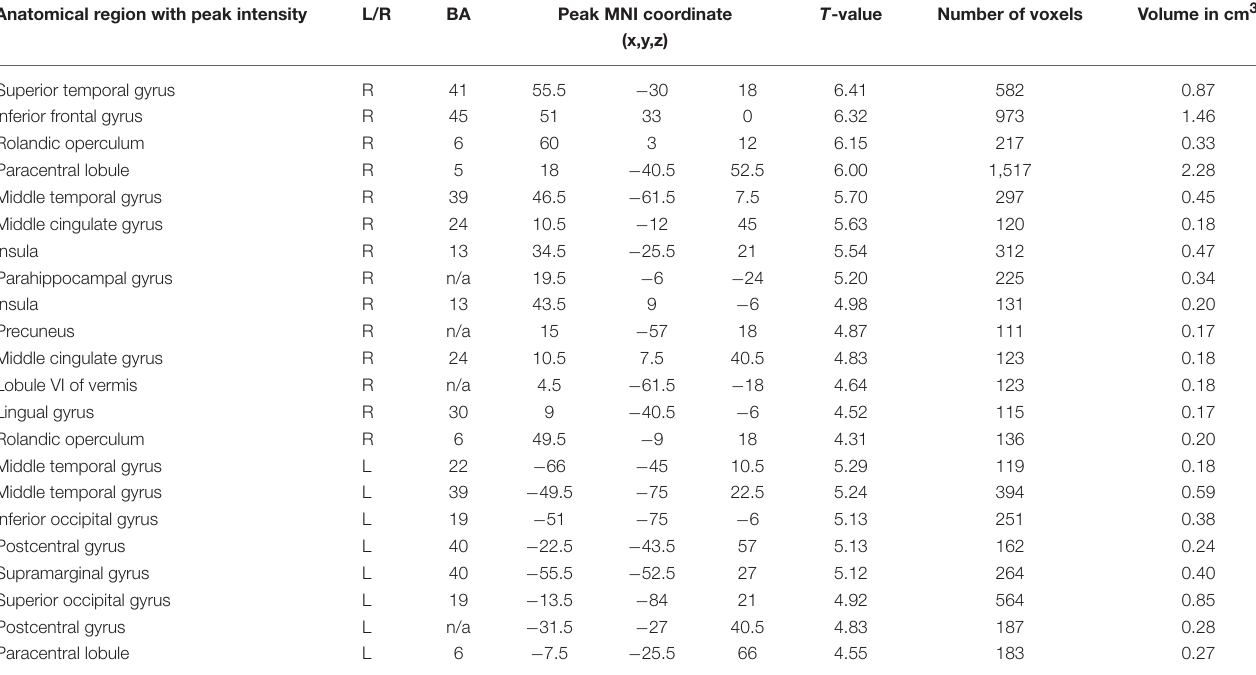
TABLE 3 | Brain areas showed a significant correlation of BOLD signal with HFD (FDR corrected, p < 0.05, T < 3.47, cluster threshold > 100). Anatomical region with peak intensity L/R BA Peak MNI coordinate